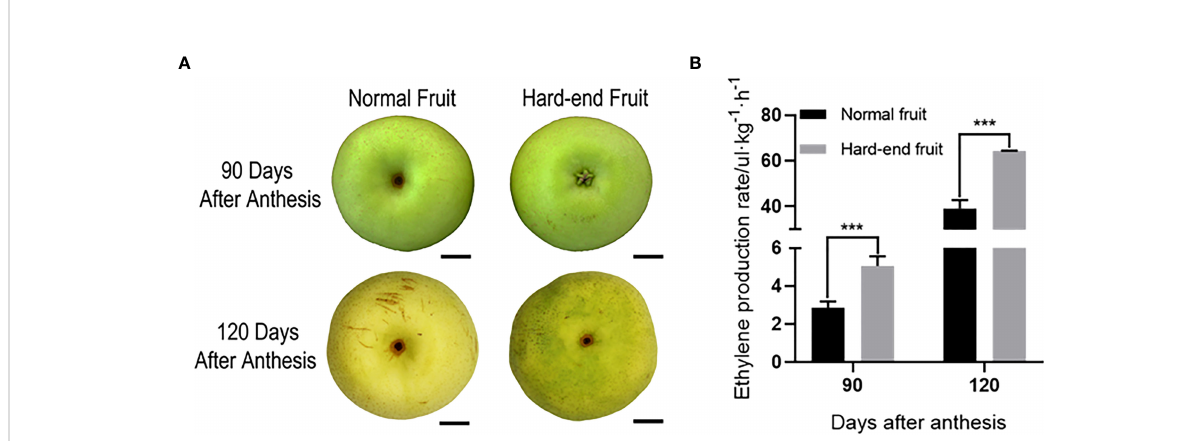
FIGURE 1 Ethylene production rate of ‘ Whangkeumbae ’ at 90 and 120 days after anthesis. (A) Phenotypes of normal and hard-end fruit of pear ‘ Whangkeumbae ’ at 90 and 120 days after anthesis. Scale bars = 150 m m. (B) Ethylene production rate of normal and hard-end fruit at 90 and 120 days after anthesis. Data are given as mean ± SD (n = 4). The asterisk represents a signi fi cant difference ( ***p < 0.001; Student ’ s t-test